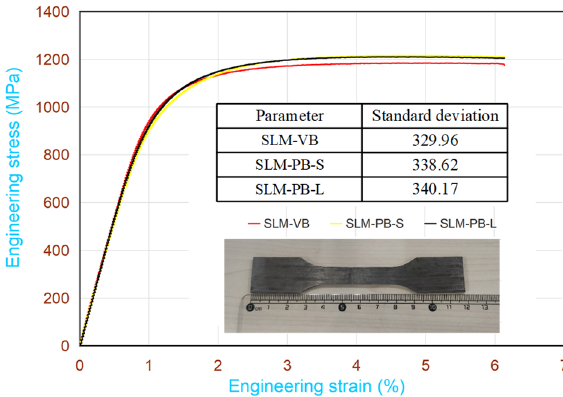
Figure 8. Stress-strain curves for tensile tests. Figure 8. Stress–strain curves for tensile tests. Figure 8. Stress–strain curves for tensile tests.